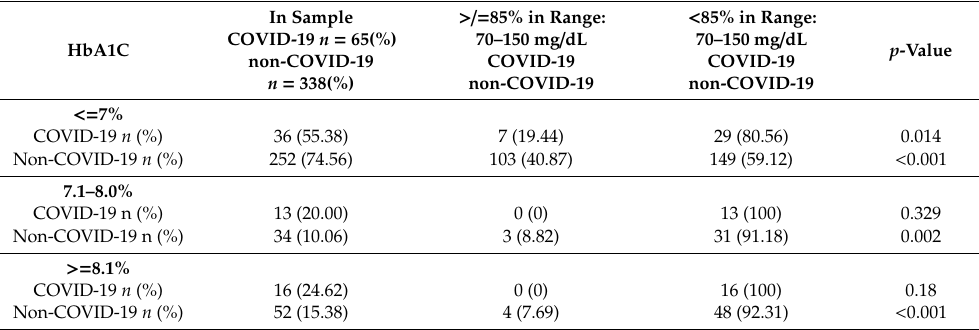
Figure 4. Multivariate analysis with odds ratio (OR) and confidence interval (CI) for mortality in the study population. Other variables adjusted but did not show statistical significance were glucose levels, gender, race, underlying comorbid conditions, proning, paralytics, insulin use, corticosteroids, and vasopressors.